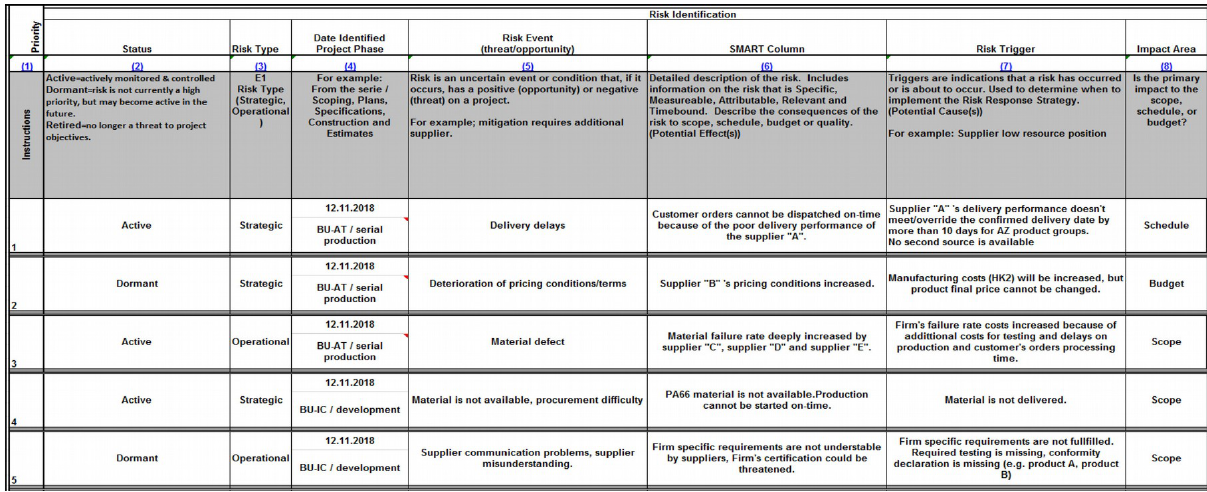
Figure 7. SCRM plan (a). Case study